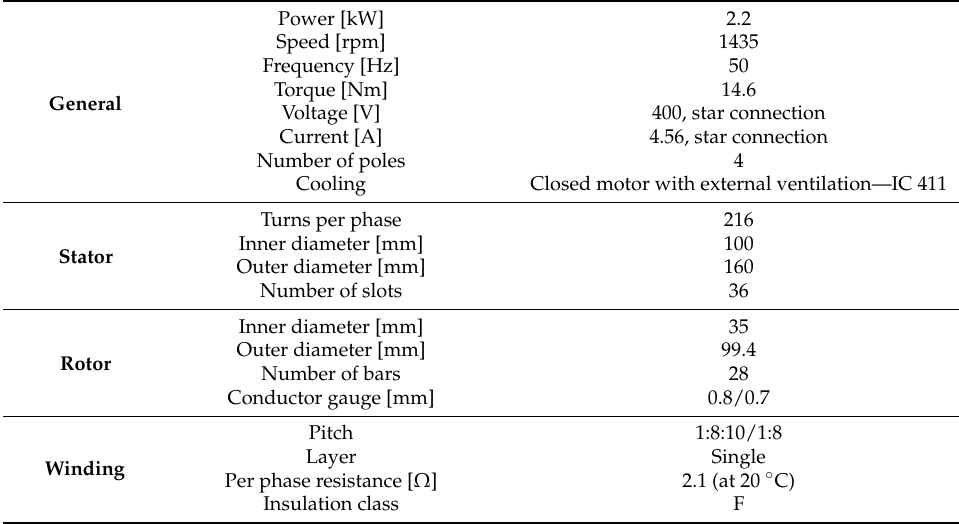
Table 3. Induction motor specifications and technical parameters.